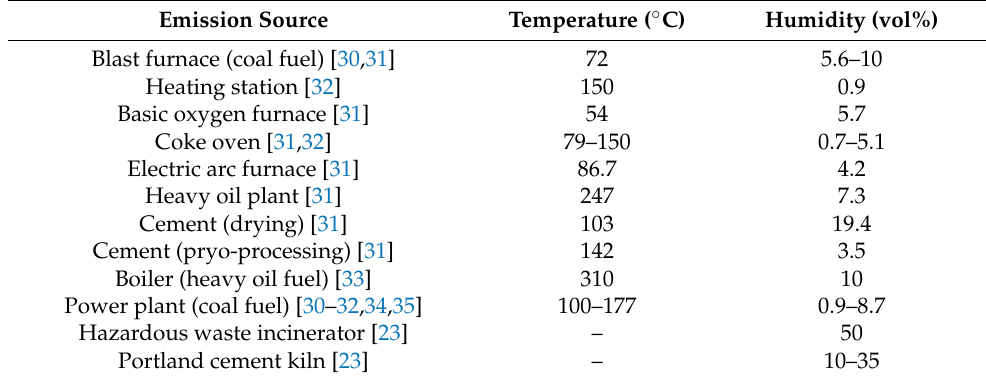
Table 1. Humidity in the flue gas of some industrial